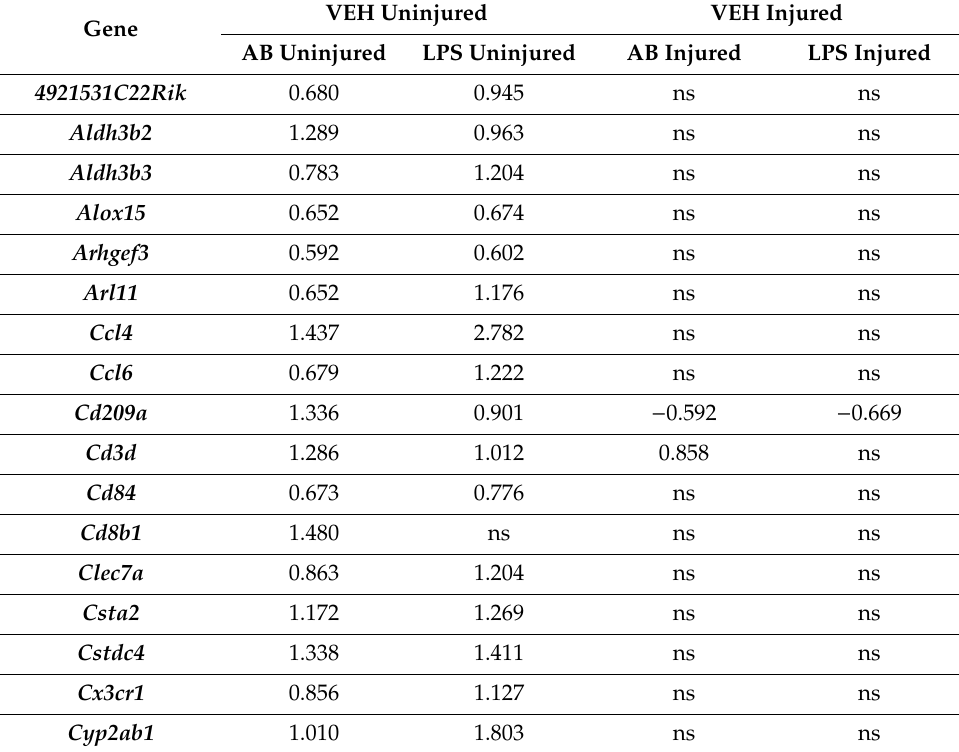
Table 3. Overlap of upregulated genes between the AB and LPS groups compared to the VEH showing the expression levels. Fold change (log2 scale) values are shown in the table (FDR < 0.05 for all genes). Changes that were not significant are denoted as